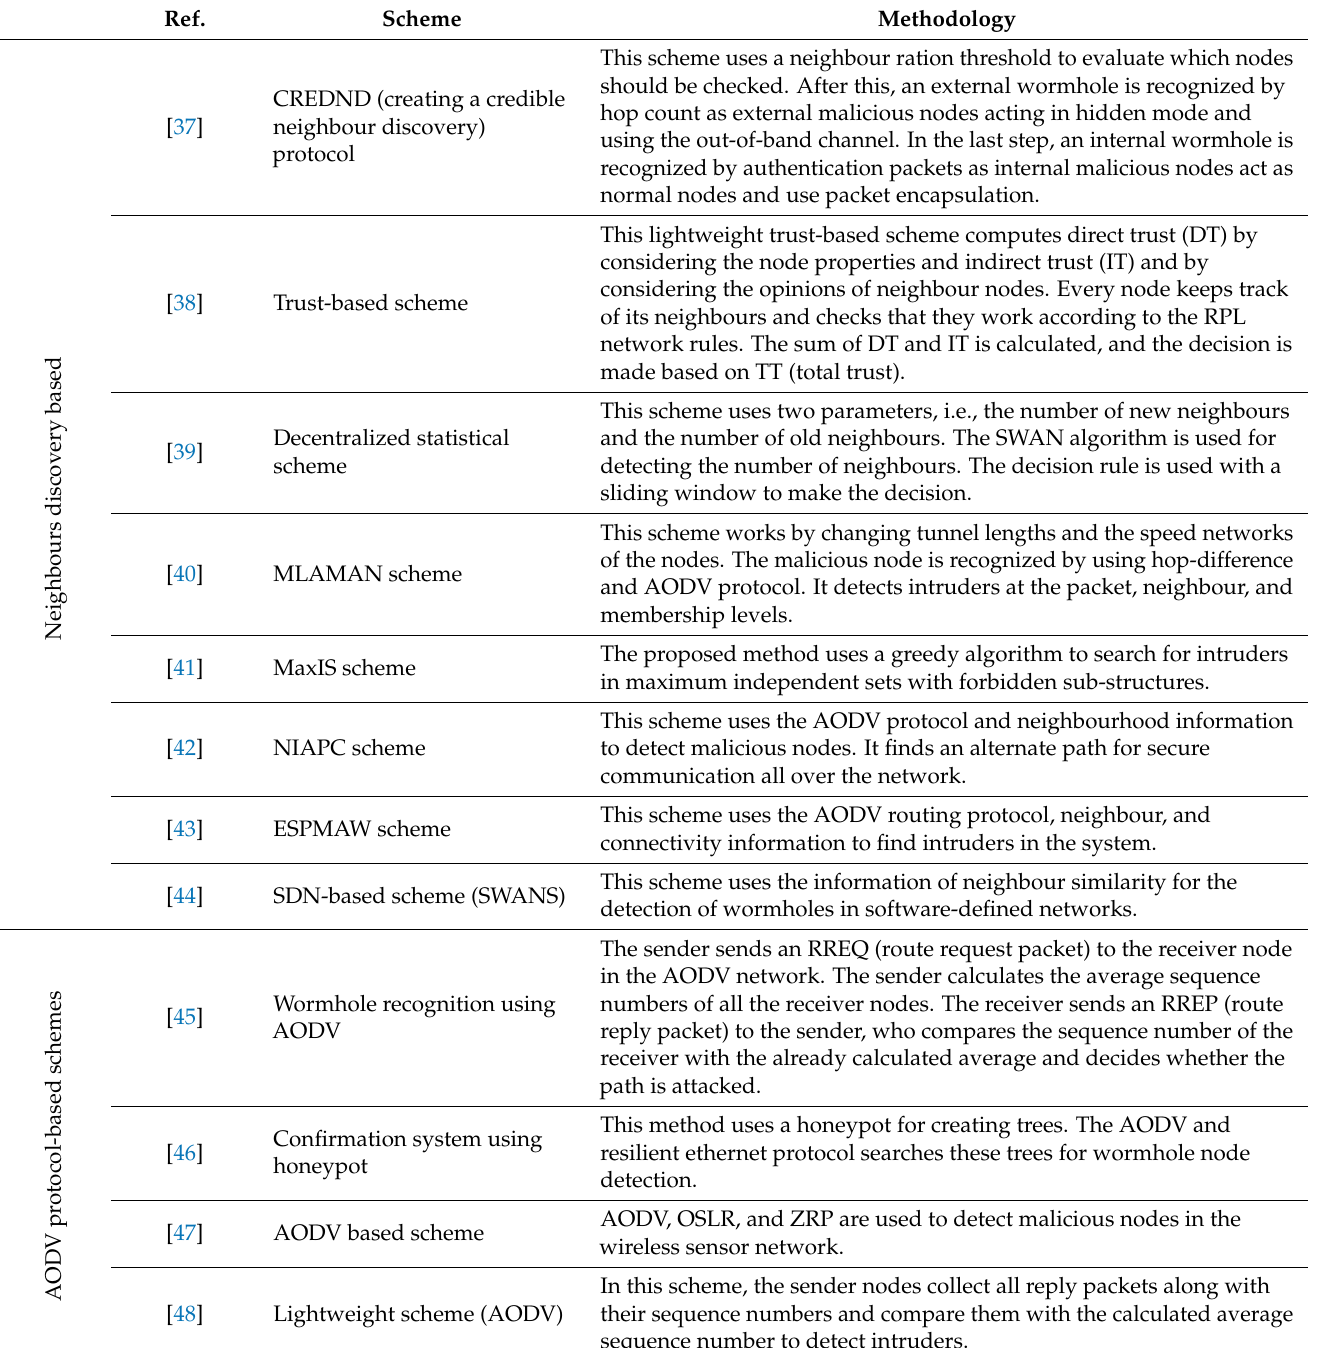
Table 4. Summary of methodologies of wormhole detection schemes.